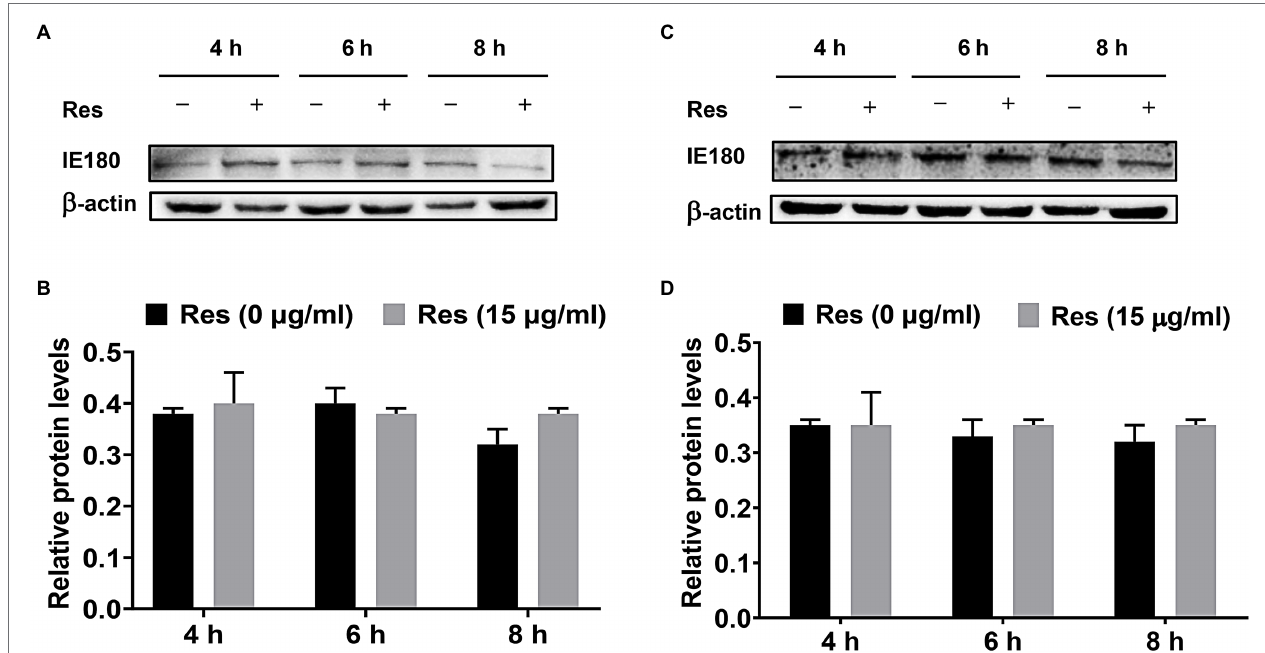
FIGURE 2 | Effect of Res on IE180 protein expression. (A,B) PK-15 cells were infected with PRV (MOI = 5) for 1 h, followed by treatment with or without 15 μ g/ml of Res at a different time (4, 6, and 8 h). (C,D) In the over-expression assay, the recombinant pIE180 was transfected into cells for 24 h followed by infection with PRV (MOI = 5) for 1 h. The cells were then treated with or without Res (15 μ g/ml) at various times (4, 6, and 8 h). The expressions of IE180 protein were performed by western blotting and were corrected according to the levels of β -actin. Graphs show mean ± SD ( n =